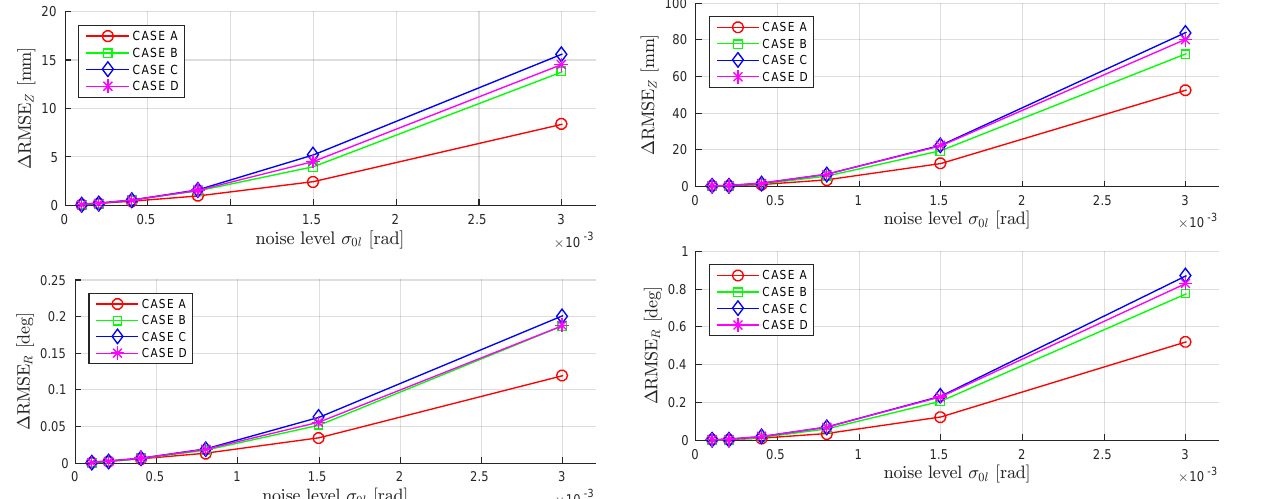
Figure 6. Deviations between the RMSE of estimated camera positions and rotations of ideal result and approximations C ASE A-D at different noise levels σ 0 l of dataset B UILDING .